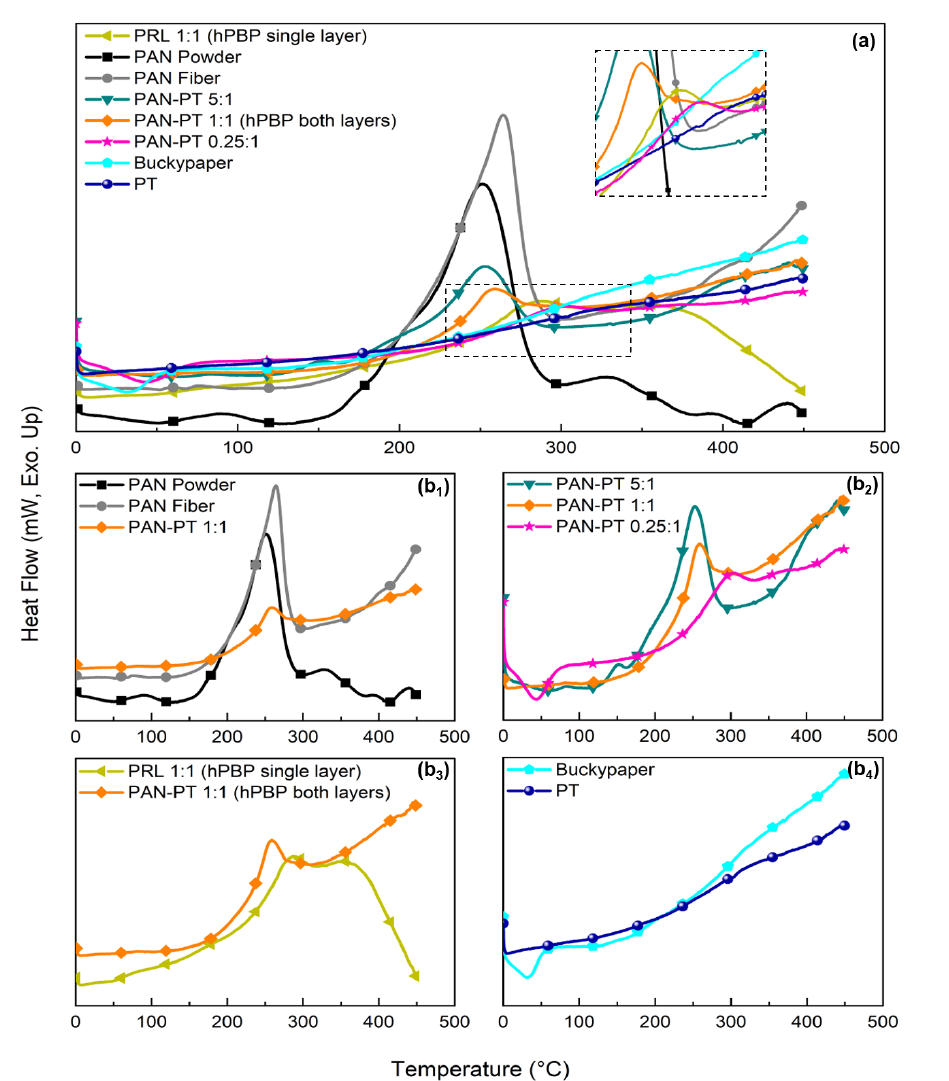
Figure 8. ( a ) Differential Scanning Calorimtery (DSC) curves for PAN powder, PAN fiber, a hPBP single (PRL) and two-layered films showing the exotherm associated with PAN cyclization. The absence of an exotherm indicates that no PAN is present. The inset magnifies the exothermic peak for the hPBP single (PRL) and two-layered films. ( b 1 ) A comparison of PAN powder/pellets, fibers, and hPBP showing a shift in the exotherm as the PAN chains become more confined due to material morphology. ( b 2 ) A comparison of hPBPs with decreasing PAN:SWNT ratios, where PAN confinement becomes more pronounced due to the removal of excess ’non-interacting/blended’ PAN. ( b 3 ) A comparison of the two-layered and single-layer hPBP showing an exotherm shift due to even more confinement as the isolated blended region (PRL) is studied. ( b 4 ) Buckypaper and SWNT powder (PT) showing no exotherm as no PAN is